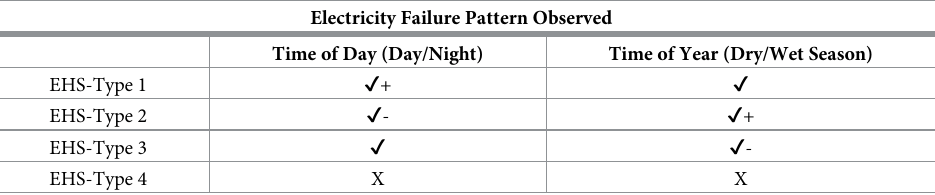
Table 1. Qualitative pattern justification in choosing these four EHS